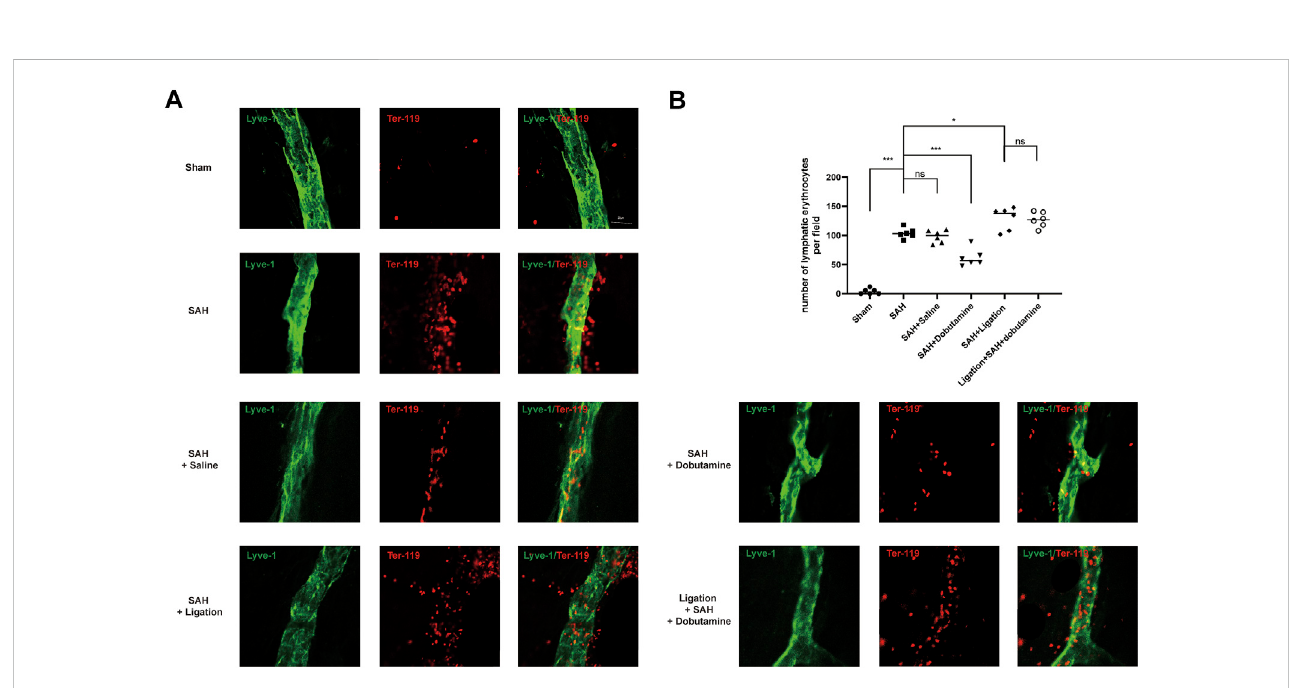
FIGURE 6 Dobutamine promoted the drainage of RBCs from the SAS to dCLNs via mLVs. (A) Representative immuno fl uorescence staining of RBCs and mLVs in different groups. (B) Quantitative analysis of the number of lymphatic erythrocytes per fi eld in mLVs. Data are presented as the mean ± SD ( n = 6 mice, ** p < 0.01, and *** p <